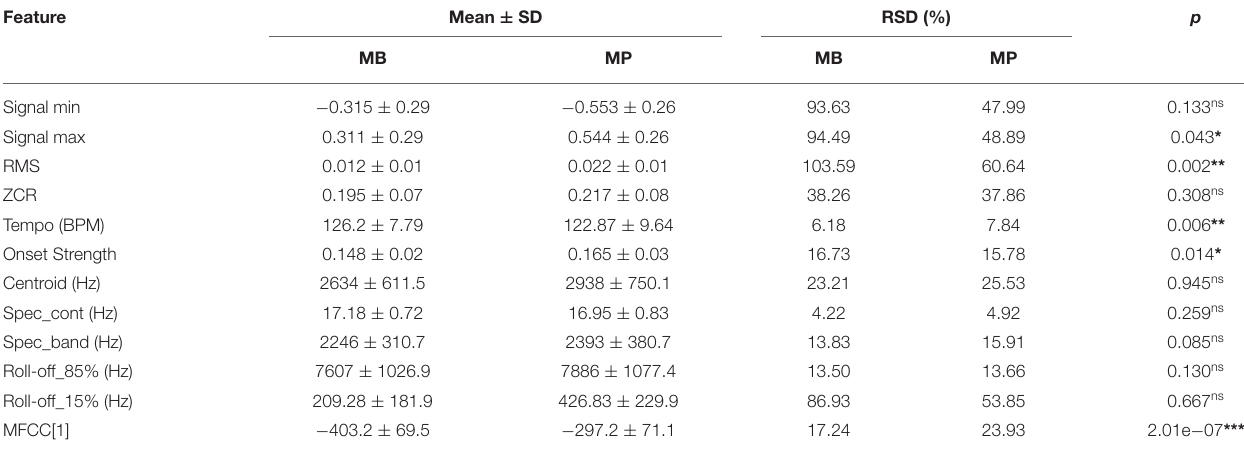
TABLE 1 | Mean standard deviation (SD) and relative standard deviation (RSD) for different features extracted from audio recordings of Brazilian horses gaiting ± according to different patterns ( Marcha Batida —MB and Marcha Picada